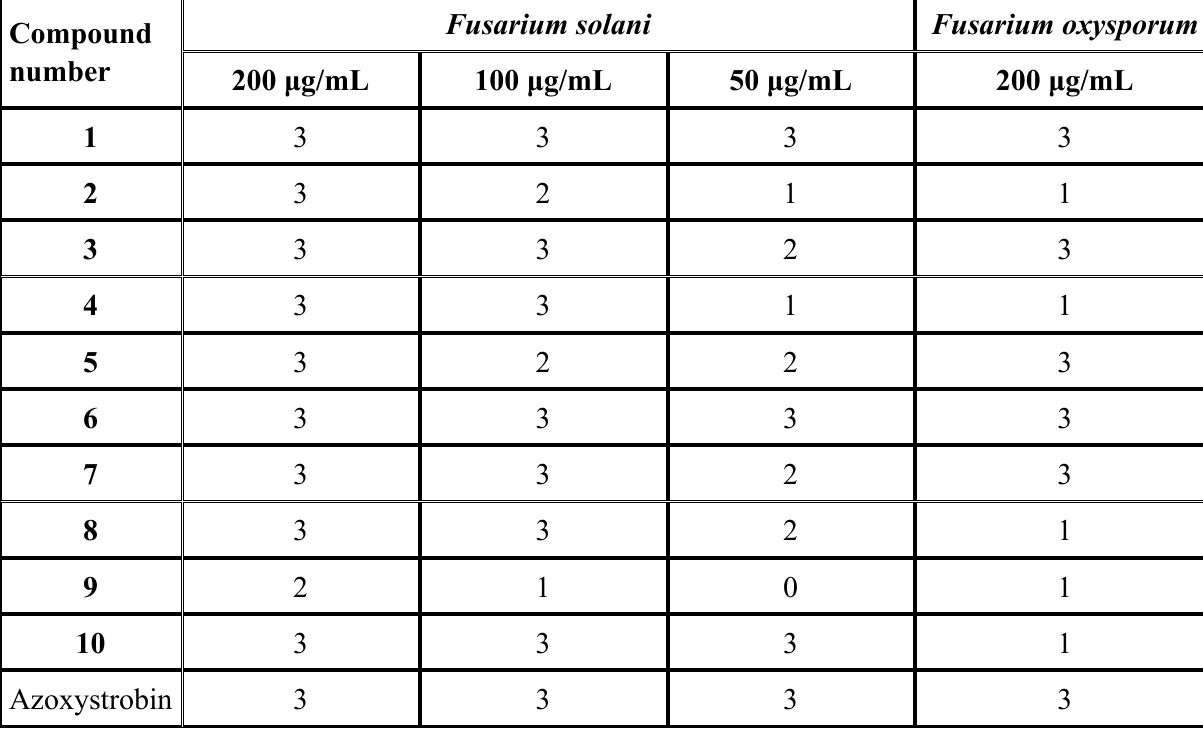
Table 3. The fungicidal activity of the studied compounds against Fusarium solani and Fusarium oxysporum .